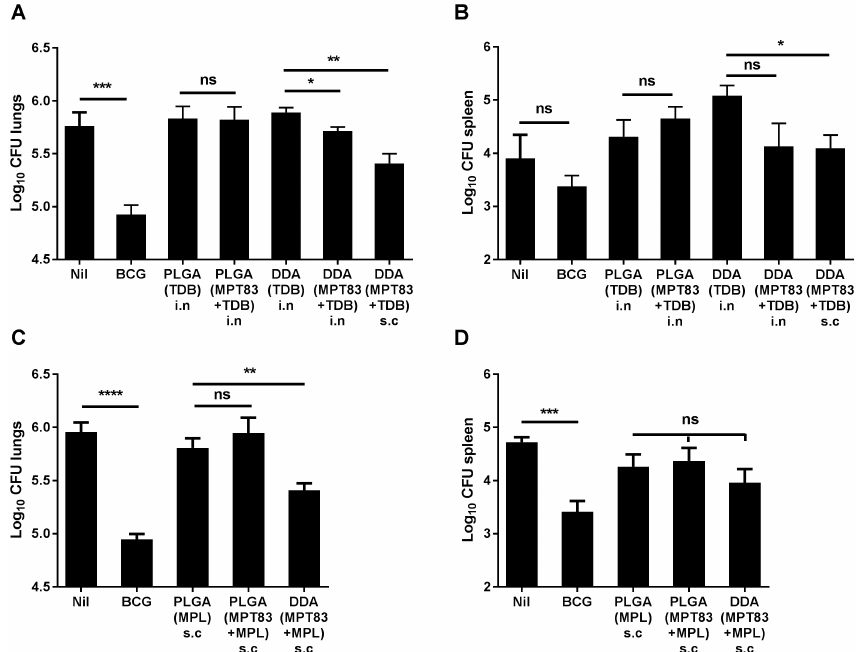
containing MPT83 adjuvanted with TDB, (A) lungs and (B) spleen, or adjuvanted with MPL, (C) lungs and (D) spleen. Six weeks following the final vaccination, mice were challenged with a low-dose aerosol of M . tuberculosis H37Rv (100 CFU). Additional mice (n = 6) were immunised with 5 × 10 5 CFU BCG once by s.c injection 12 weeks before challenge. After 4 weeks the bacterial loads were enumerated in mice immunised either i.n or s.c as indicated. The data are the means ± SEM. Statistical significance was determined by Student’s t -test, comparing the vaccinated group to the relevant unimmunised/adjuvant only control ( (cid:3) p < 0.05, (cid:3)(cid:3) p < 0.01, (cid:3)(cid:3)(cid:3) p < 0.001, (cid:3)(cid:3)(cid:3)(cid:3) p <